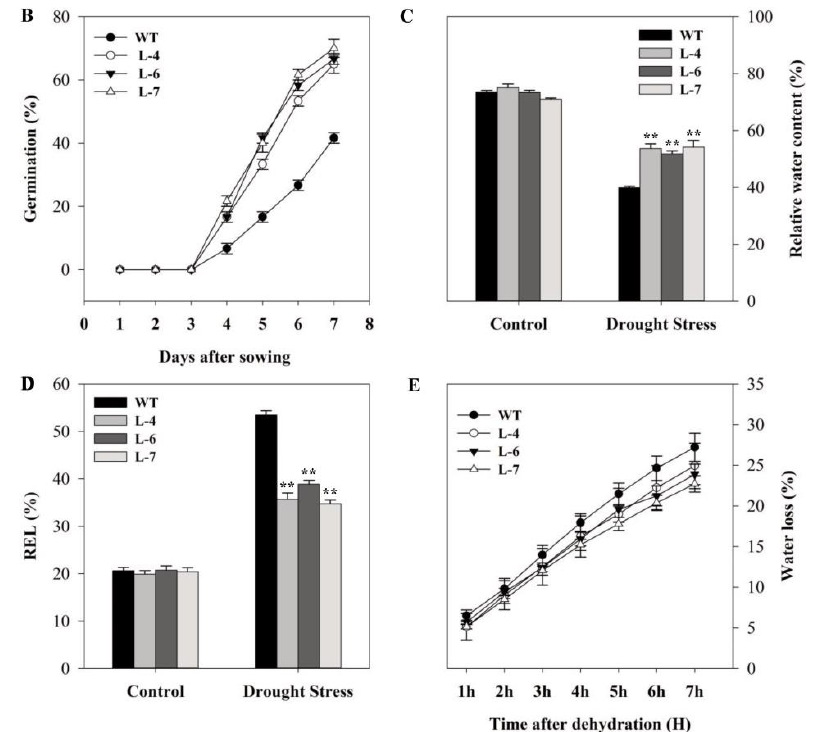
Figure 7. SlMAPK3 overexpression enhanced drought tolerance in tomato. ( A ) Seedling growth in 0 and 200 mM mannitol stress, ( B ) seed germination percentage under 200 mM mannitol stress, ( C ) relative water content, ( D ) relative electrolyte leakage, and ( E ) water loss in detached leaves. For B – E , data represent mean ± SE of three biological replicates. For C and D, ** significant level differed at p < 0.01.